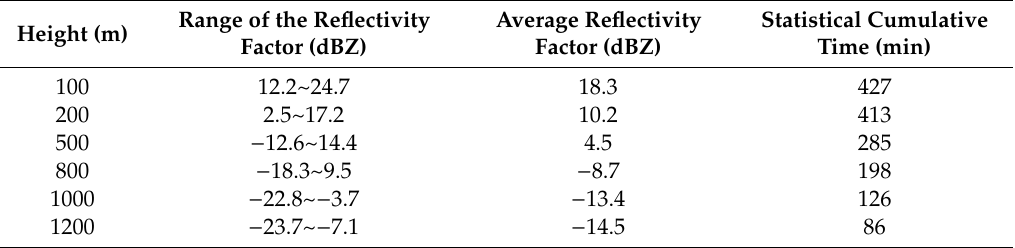
Table 4. Distribution features of reflectivity factors at different heights during the dust storm period.